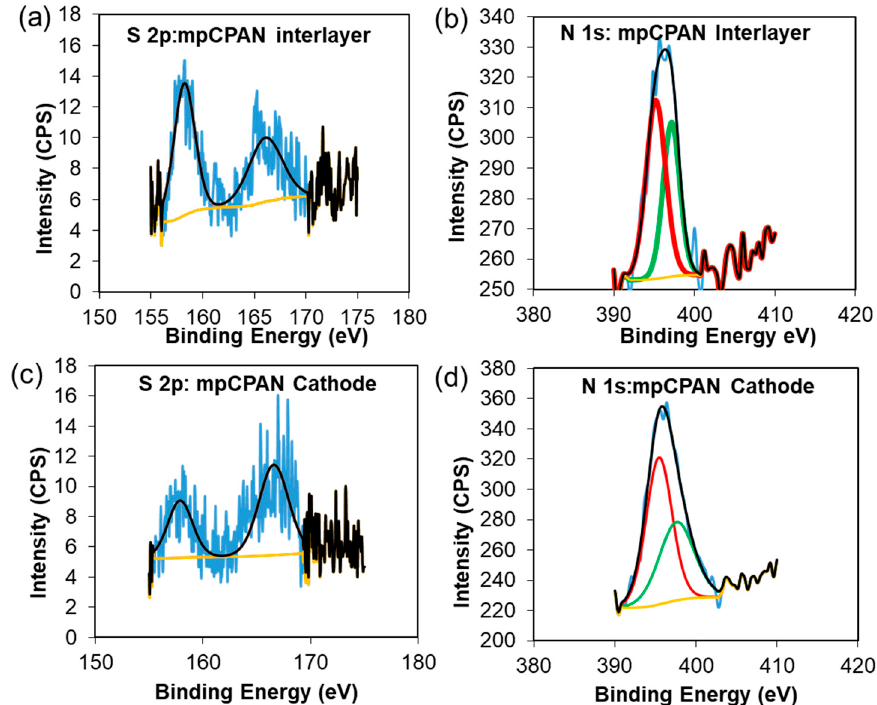
Figure 14. ( a ) High Resolution S 2p spectra of mpCPAN interlayer; ( b ) High Resolution N 1s spectra of mpCPAN interlayer; ( c ) High Resolution S 2p spectra of mpCPAN cathode; ( d ) High Resolution N 1s spectra of mpCPAN cathode.